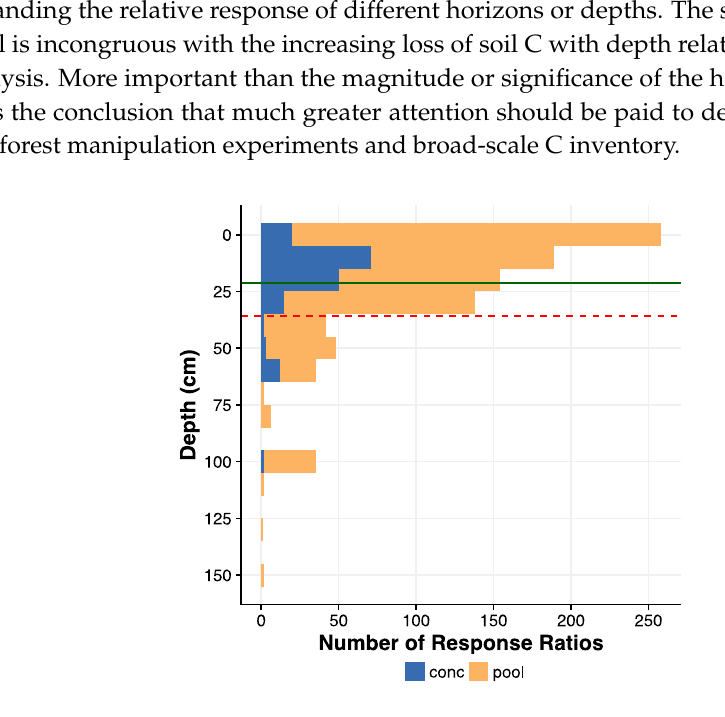
Figure 6. Number of response ratios plotted by the maximum depth of sampling for each observation. Response ratios calculated from concentration are in blue, and from pools in orange. The average depth of all response ratios is denoted by the solid green line (21.3 cm, n = 945). The average maximum sampling depth for all 112 publications in the meta ‐ analysis is denoted by the dashed red line (35.9 cm).